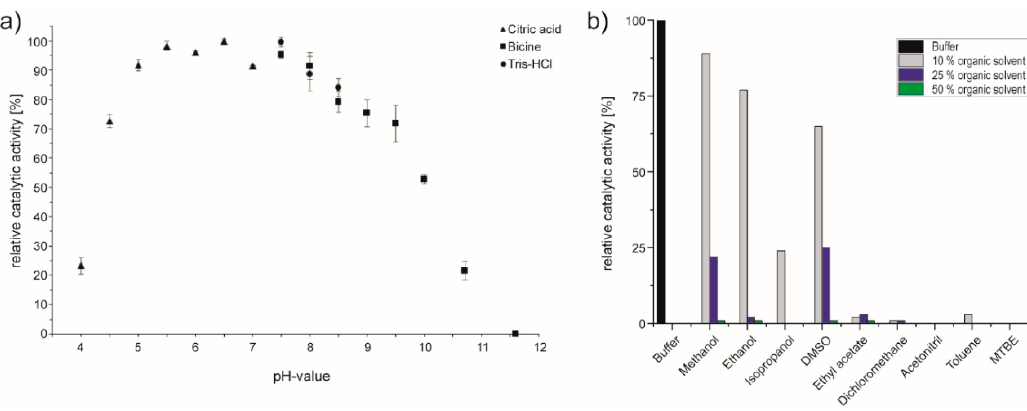
Figure 2. Ambient solution effects on the activity and stability of purified CtADH. The activity of CtADH was measured with 0.1 M propiophenone as substrate and 0.2 mM NADPH as co ‐ substrate. ( a ) pH ‐ profile of the catalytic activity of CtADH determined with three different buffer systems (Table S2). ( b ) Effect of preincubation in organic solvents at different solvent concentrations on the stability of CtADH assayed by the reduction of propiophenone. The grey bars indicate the activities when using 10% ( v / v ) organic solvent, cyan bars correspond to the activities when using 25% ( v / v ) of organic solvent and green bars correspond to the activities measured at 50% ( v / v ) of organic solvent.